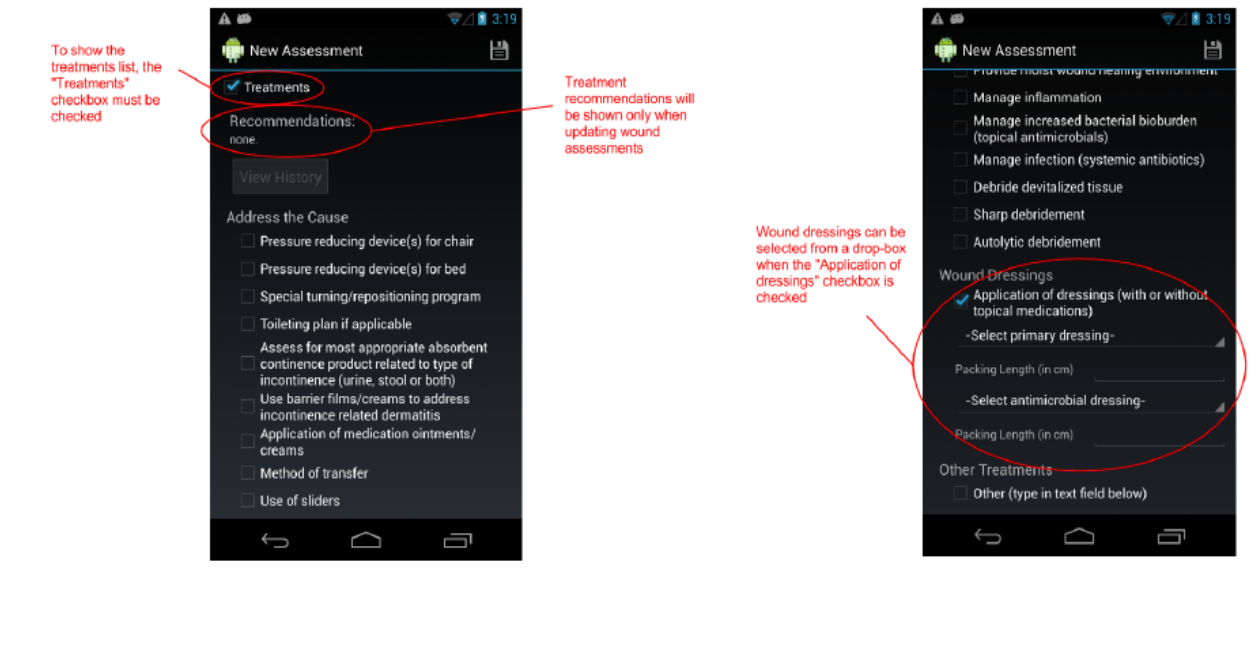
Figure 6. The New Assessment screen continued. A large list of treatments may be selected when the “Treatments” checkbox is checked. Recommendations may be provided when reassessing a